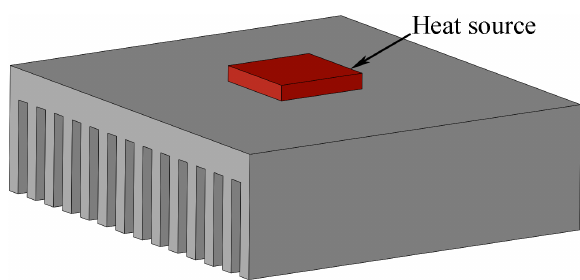
Fig. 1. Radiator structure with fin array distribution with rectangle shape heating area